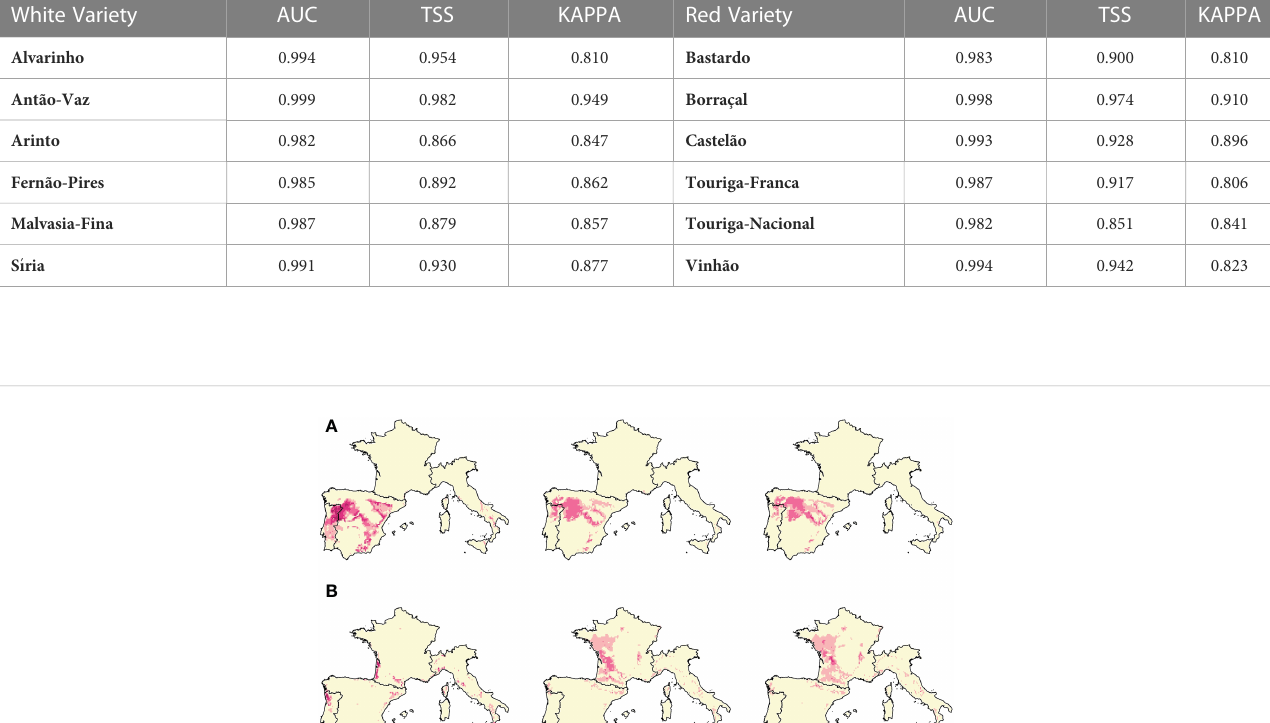
TABLE 2 - Ensemble model metric scores for each grape variety. White Variety